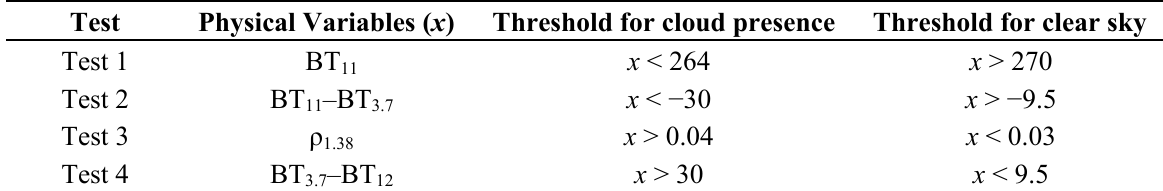
Table 1. Physical variables and threshold values for the four cloud tests analyzed in this work.